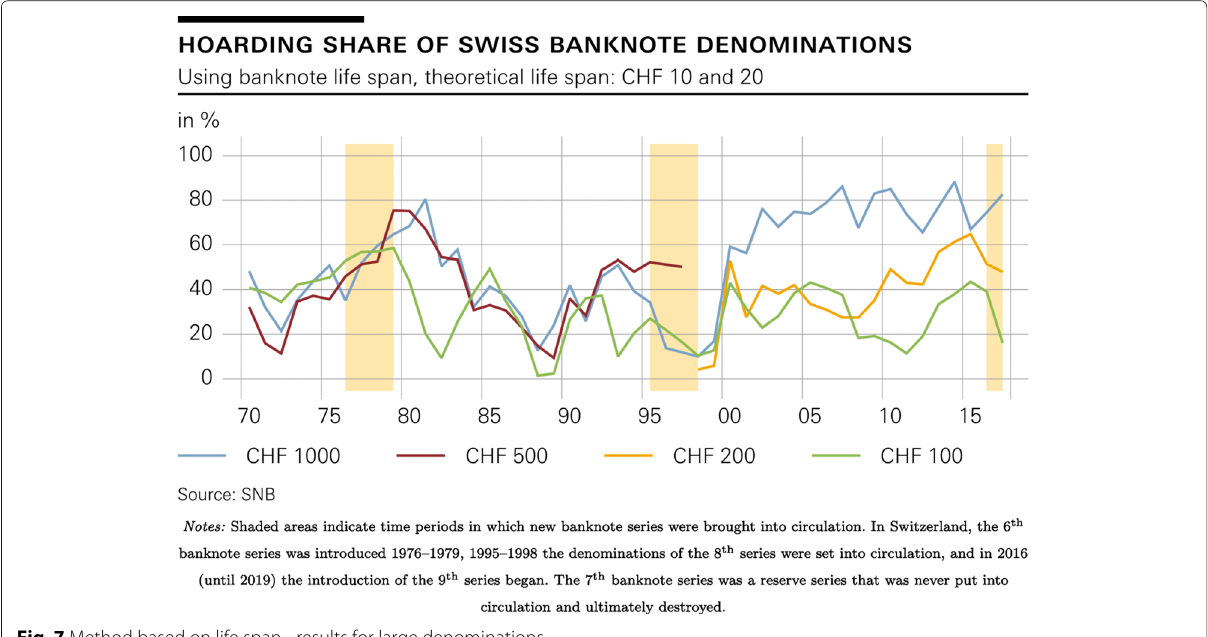
Fig. 7 Method based on life span - results for large